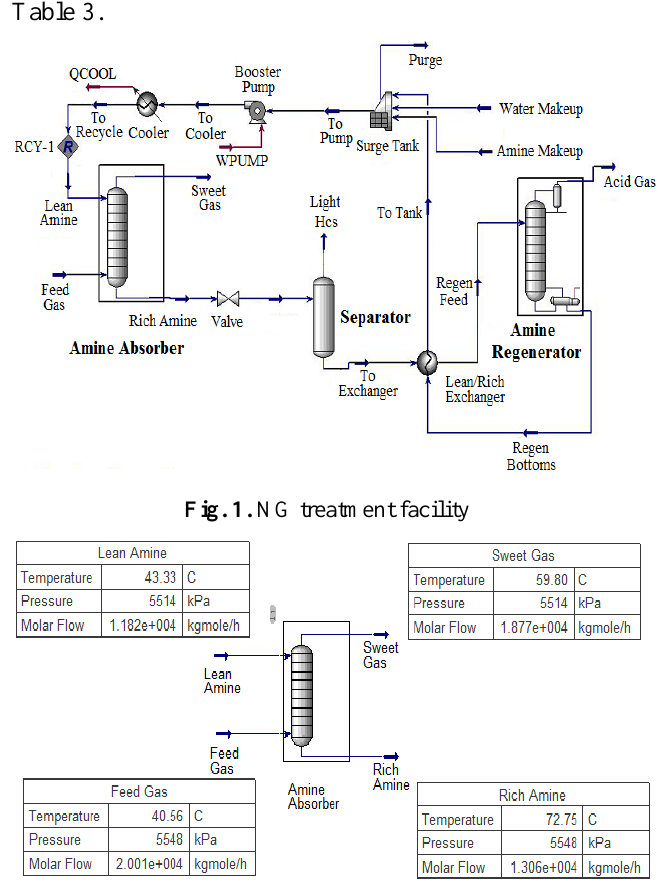
Fig. 2. Amine Absorber flow sheet case with 25 mol%